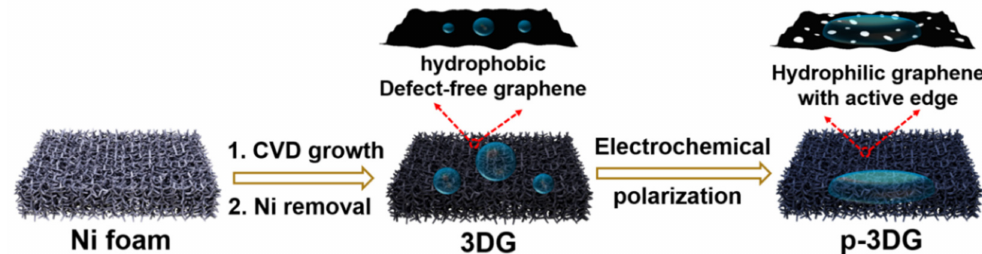
Figure 1. Schematic illustration for the preparation of p-3DG through electrochemical polarization of CVD-grown